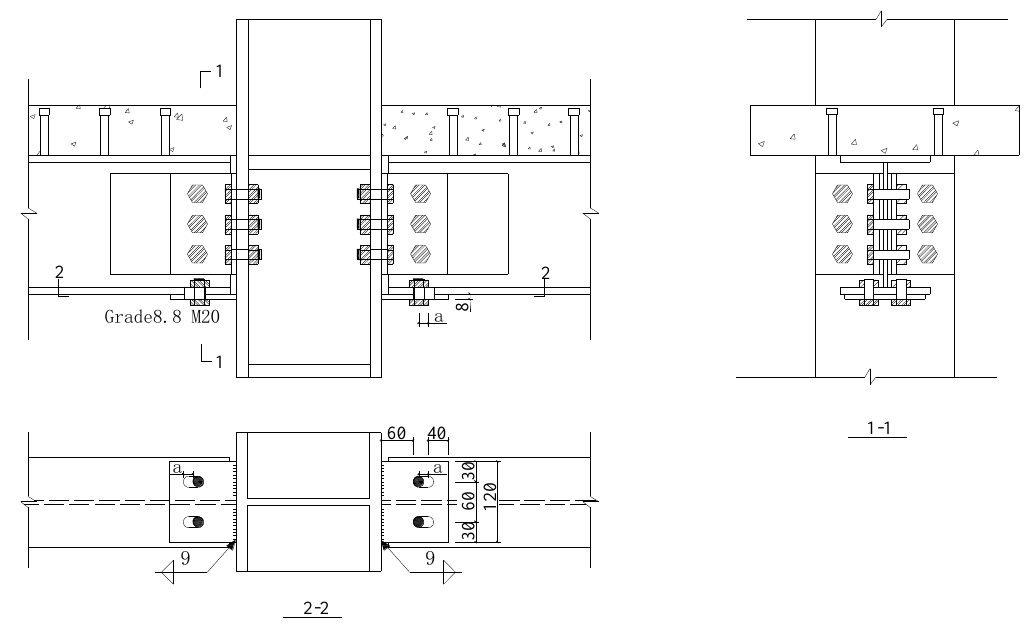
Figure 18. Retrofit strategy 2 (unit: mm).